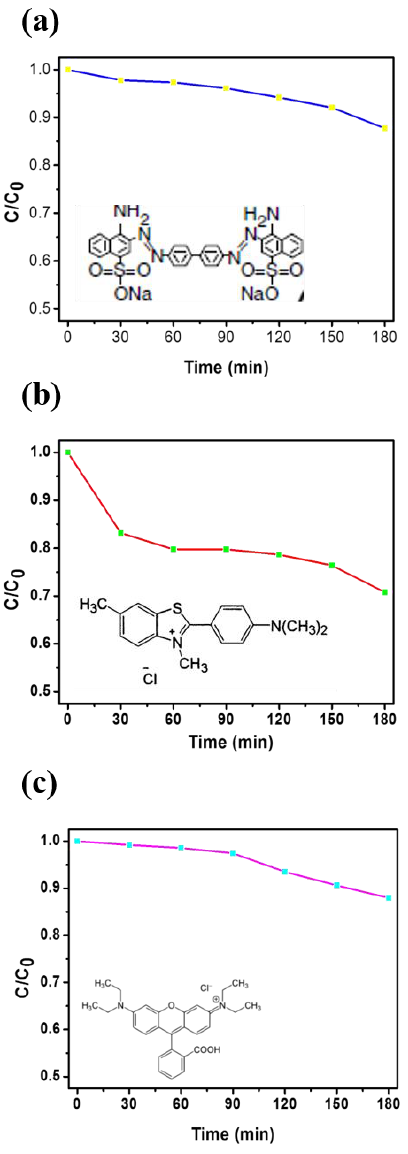
Figure 8. The removal e ffi ciency of pure carbon NF membrane towards ( a ) CR, ( b ) BY, ( c ) Rh B aqueous solutions.